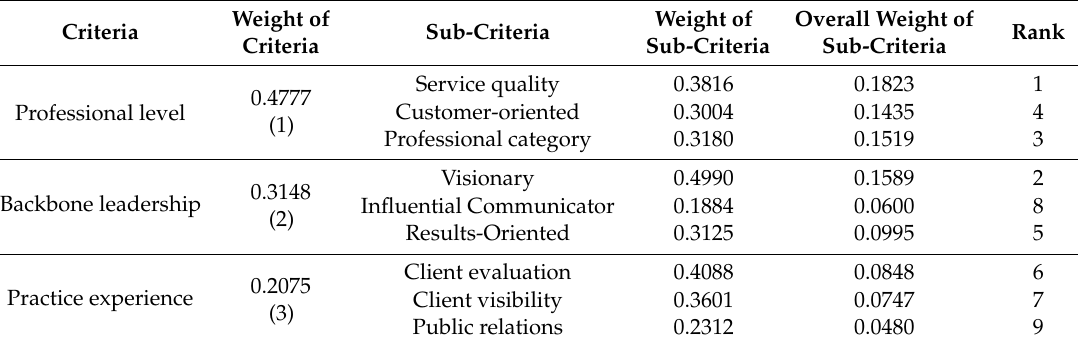
Table 8. Weights of criteria and sub-criteria.